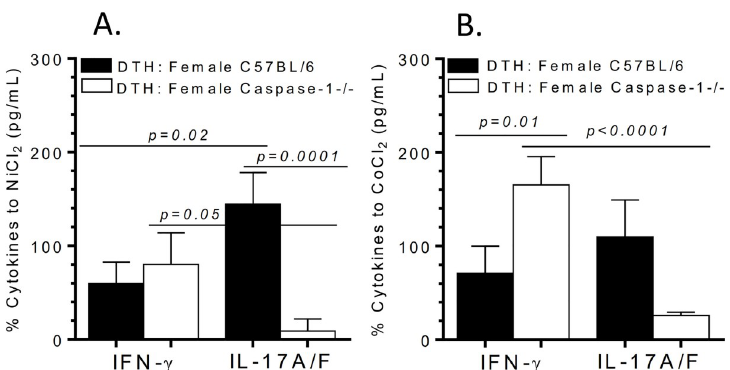
Fig 4. Metal-sensitized caspase-1 knockout female (DTH: Female caspase-1 -/-) mice produce IFN-gamma dominated T-cell responses to implant metal-challenge. Percentage increase of lymphocyte cytokine production of IFN-gamma or IL-17A/F in response to (A) Ni challenge and (B) Co challenge; calculated using cytokine production to metal(s) vs. respective negative control media cell cytokine production from female metal-DTH BL/6 and Caspase-1 -/- mice. Data represents two independent experiments with n = 4–5 mice/group in each experiment. Data are shown as the mean ± SEM. Statistical significance was determined by unpaired Mann-Whitney test.